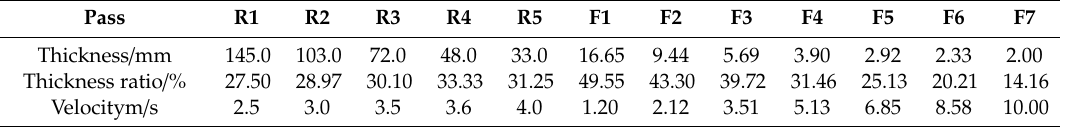
Table 4. Rolling schedule of Q235 steel used in actual production process